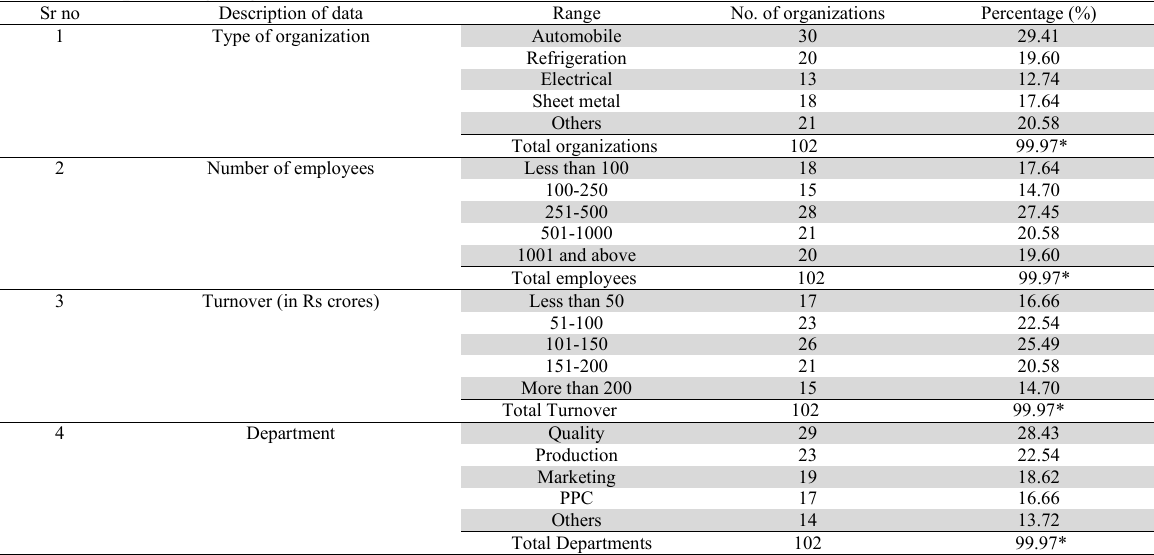
Data of responding organizations